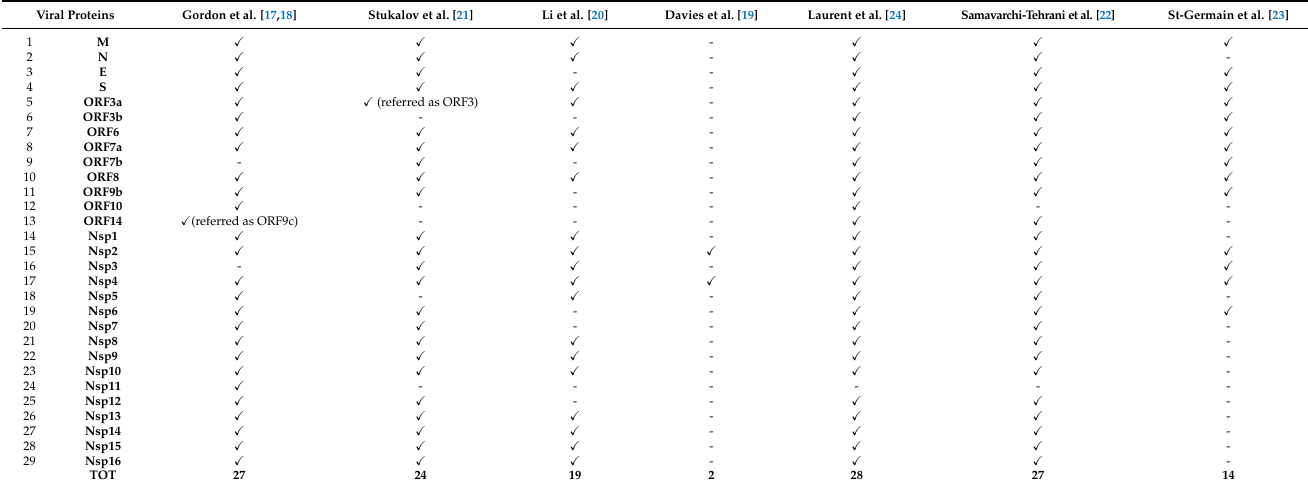
If a viral protein has been studied in the indicated report, it is marked with the symbol “ (cid:88) ”. If a viral protein has not been studied in the indicated report, it is marked with the symbol “-”. The last line of the table shows the total number of viral proteins studied in each investigation listed in the